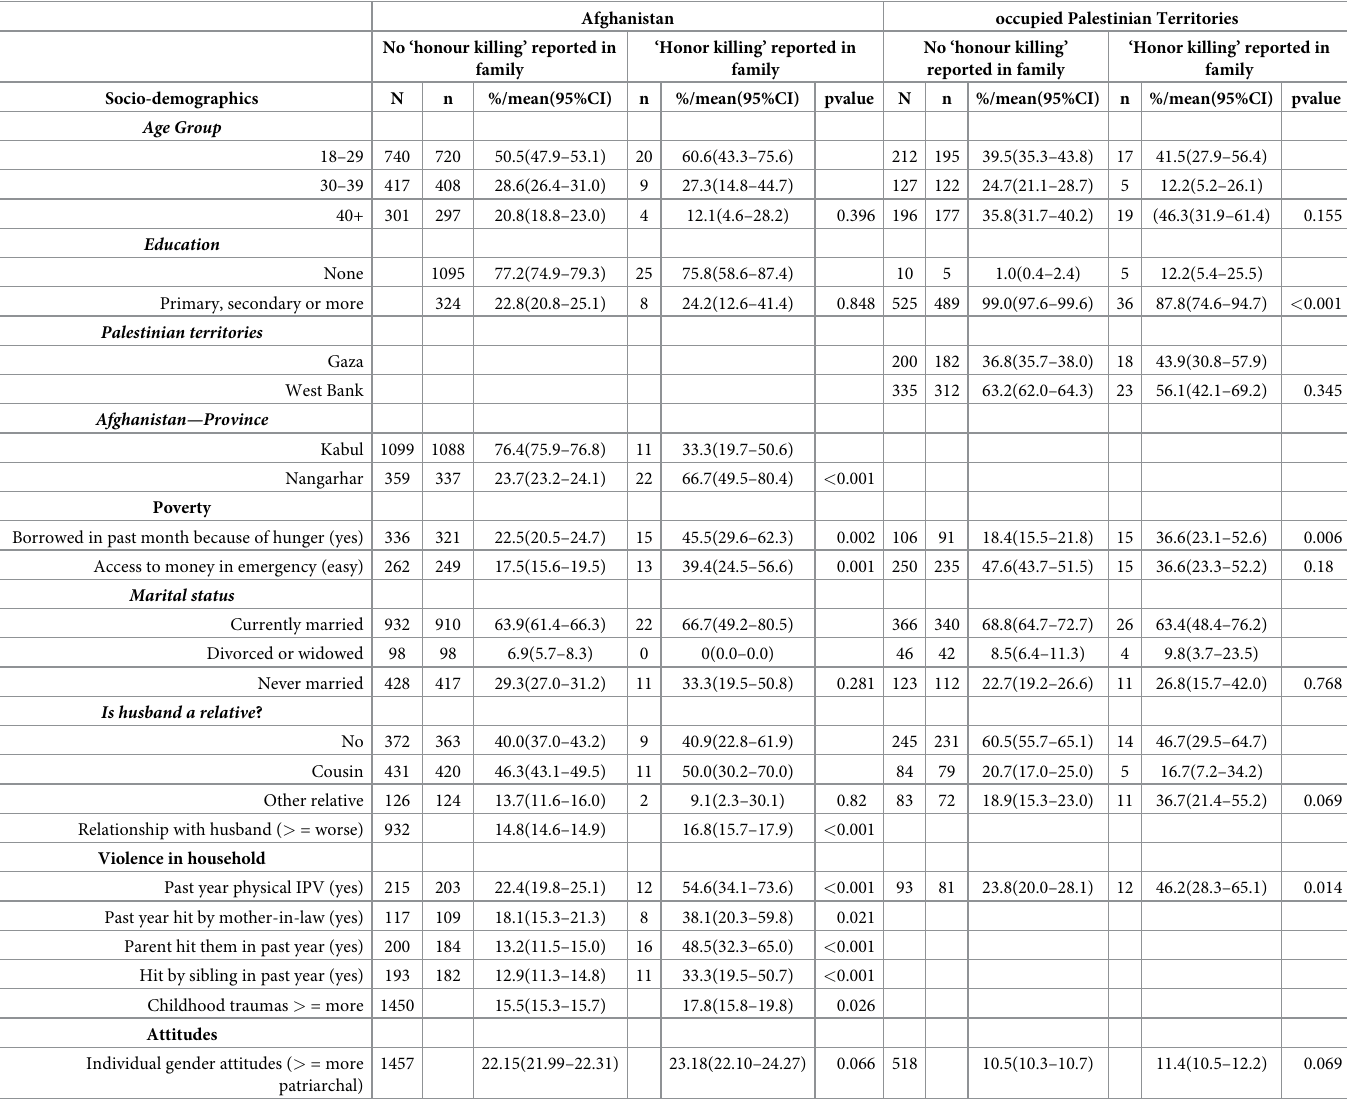
Table 2. Descriptive associations between ‘honour killing’ and socio-demographic, poverty, other forms of violence, and gender attitudes in Afghanistan and the occupied Palestinian